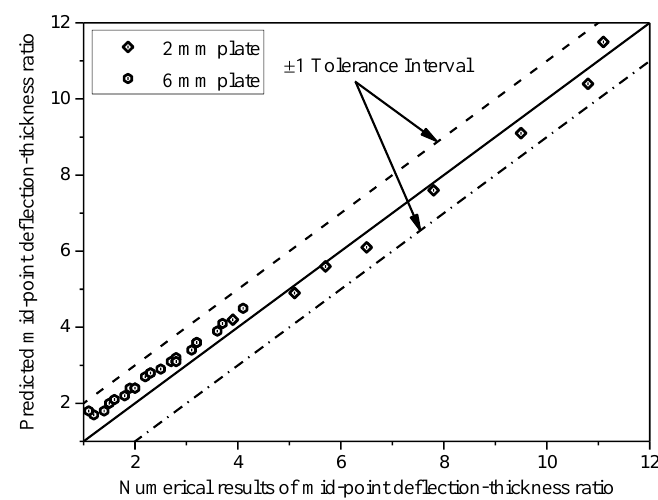
Figure 10. The predicted results versus the numerical results of the midpoint deflection–thickness ratios of the 2 mm and 6 mm target plates.